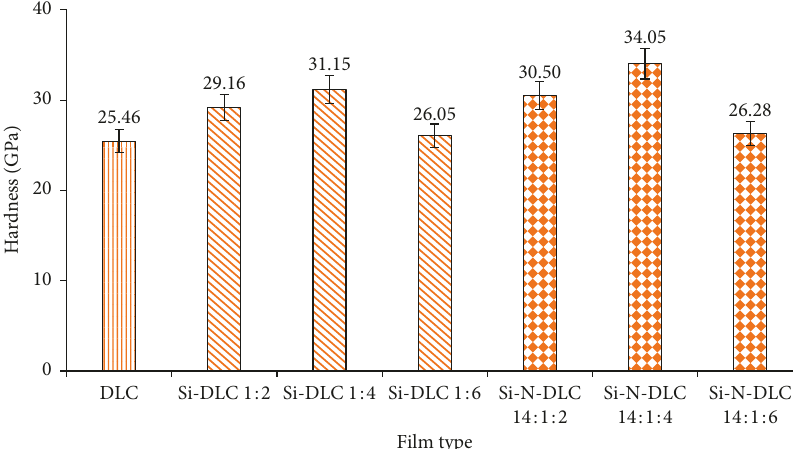
Figure 6: Hardness of pure DLC, Si-DLC, and Si-N-DLC